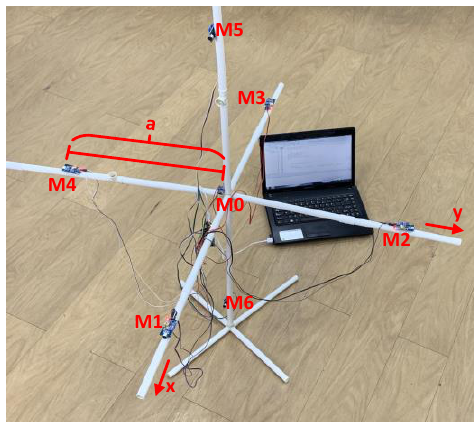
Figure 7. The scene photo of indoor experiment.